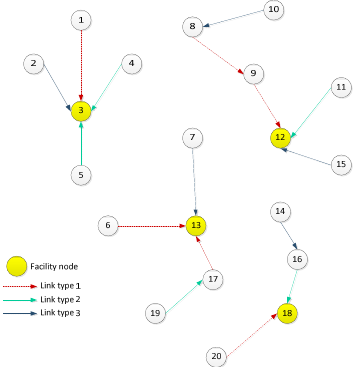
Fig. 1. The topology of the constructed